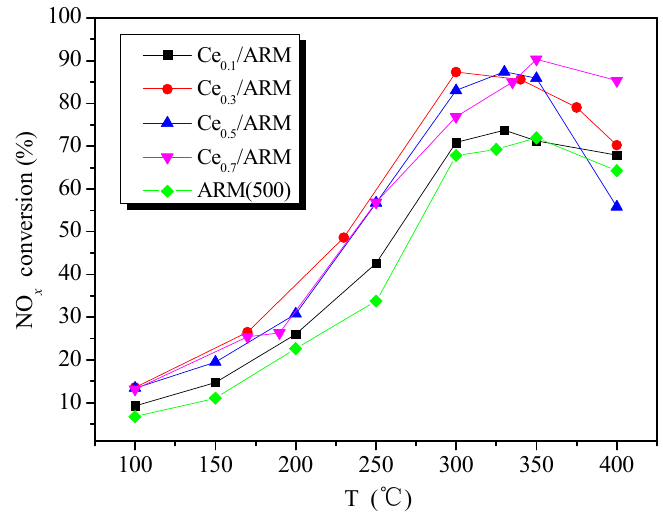
Figure 5. Catalytic activity of ARM(500) and Ce x /ARM catalysts. Reaction conditions: reaction gas pressure = 0.1 MPa, N 2 balance, total flow = 2000 mL ∙ min − 1 , GHSV = 30,000 h − 1 , [NH 3 /NO] = 1.0, initial concentration of NH 3 , NO and O 2 = 0.05%, 0.05% and >3.5%, respectively.